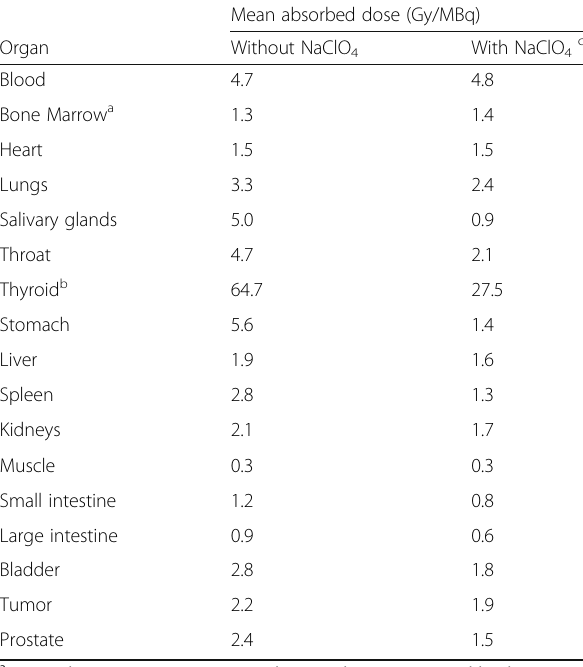
Table 2 Mean absorbed organ doses from α -RIT with 211 At- labeled A11